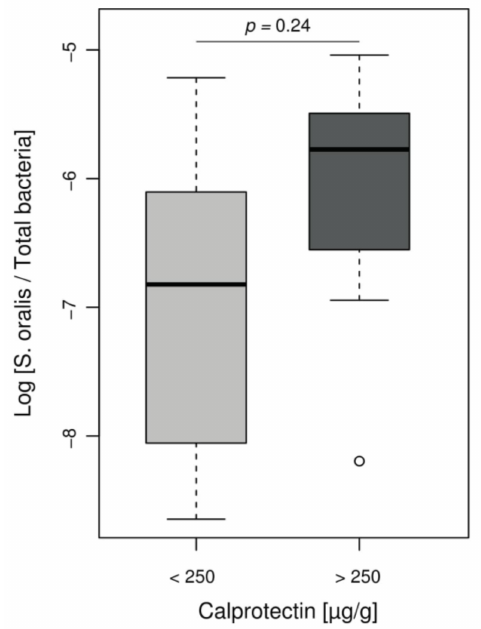
Figure 4. Relative abundance of S. oralis assessed by ddPCR according to the inflammation status of CF patients. Boxplot of values representing relative proportion of S. oralis in patients’ microbiomes, separated into groups according to calprotectin level. Among Streptococcus found in CF children, there was a notable proportion of S. oralis but without significant di ff erence between children with or without intestinal inflammation (Wilcoxon–Mann–Whitney test, p =